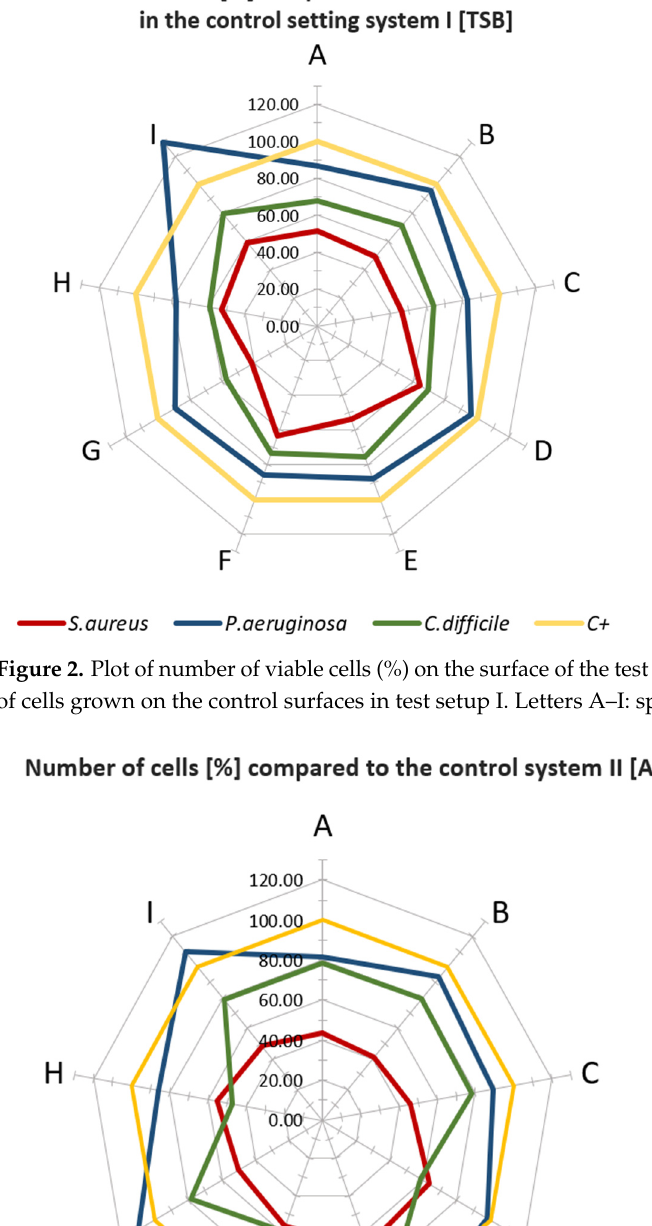
Table 5. A study based on the manufacturers’ report on the antimicrobial activity of filaments. Let- ters A–I: specific type of material analyzed.